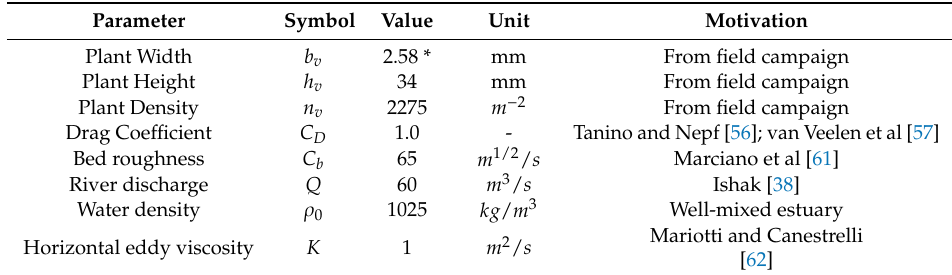
Table 4. Model input